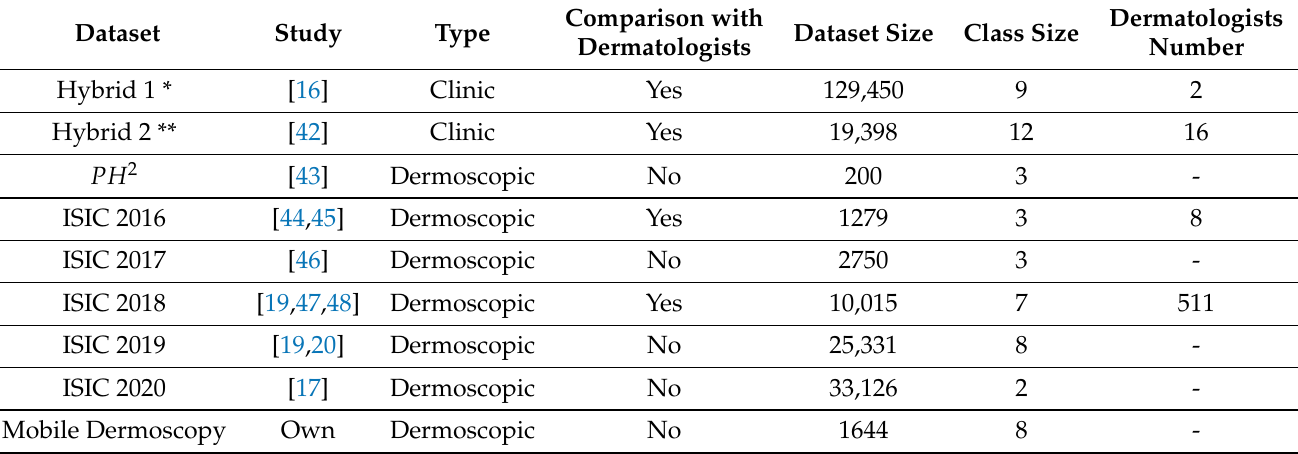
Table 6. Specifications of the largest open access skin lesion datasets in the literature and related